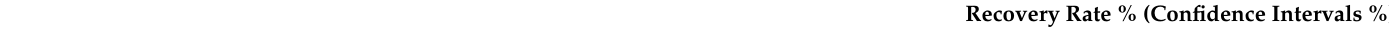
Table 6. Comparison of the recovery rates (serogroup-specific / serotype-specific RT-PCR positive heads / tested heads at 10 days post-infection) from di ff erent Italian vector populations, orally infected with BTV